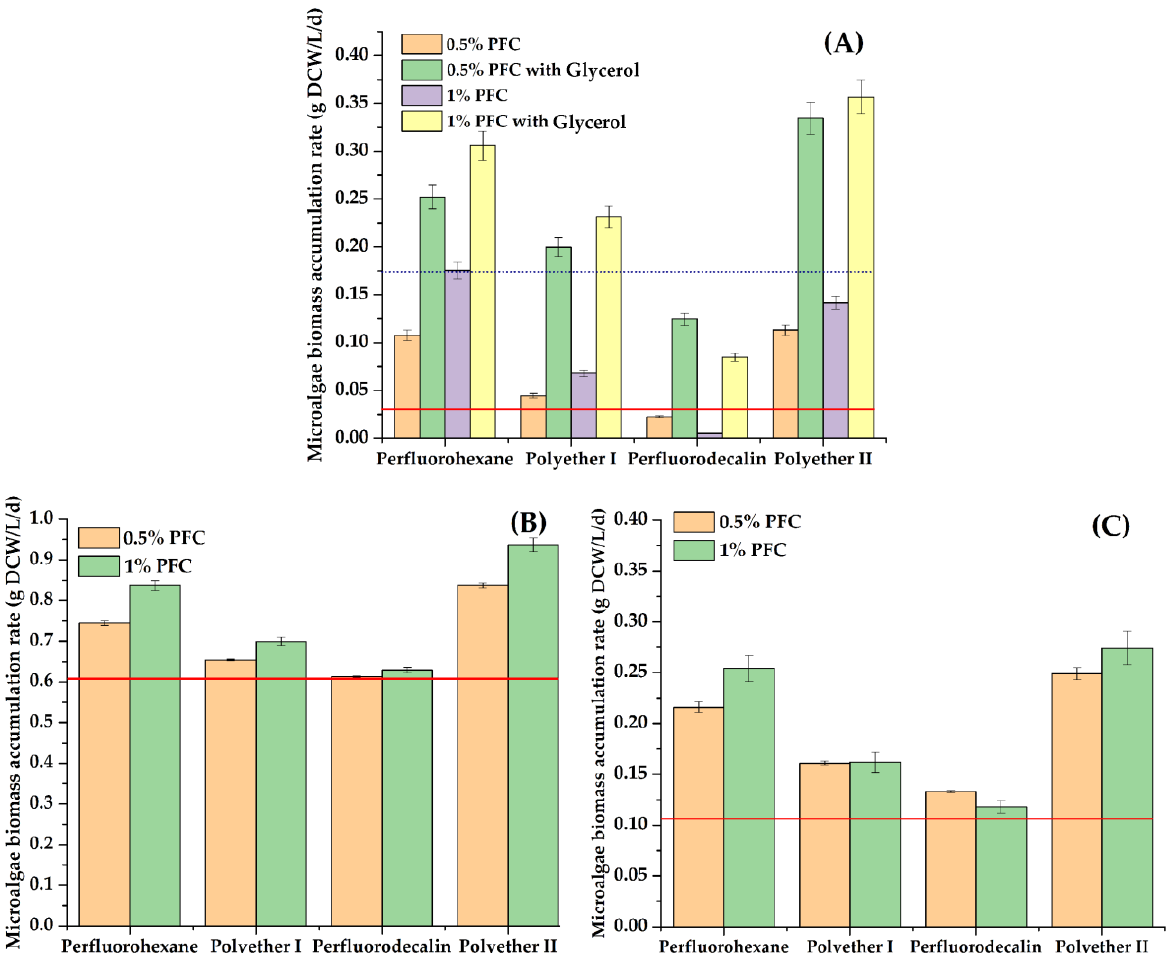
Figure 2. The average rate of biomass accumulation (g DCW/L/d) for 3 days: C. vulgaris cells in Tamiya medium ( A ), A. platensis cells in Zarrouk medium ( B ), Nostoc sp. cells in BG-11 medium ( C ). Controls: results of cultivation of cells without PFC and with 1 g/L glycerol are marked by a blue dotted line ( A ), and results of cultivation without both PFCs and glycerol are marked by a red line ( A – C